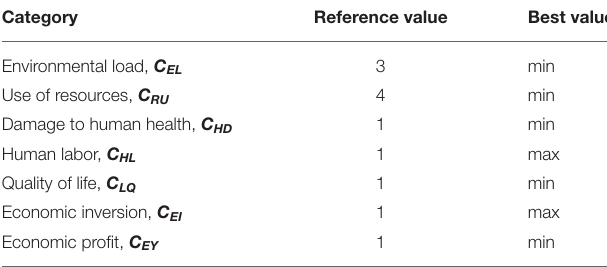
TABLE 2 | Reference value for each